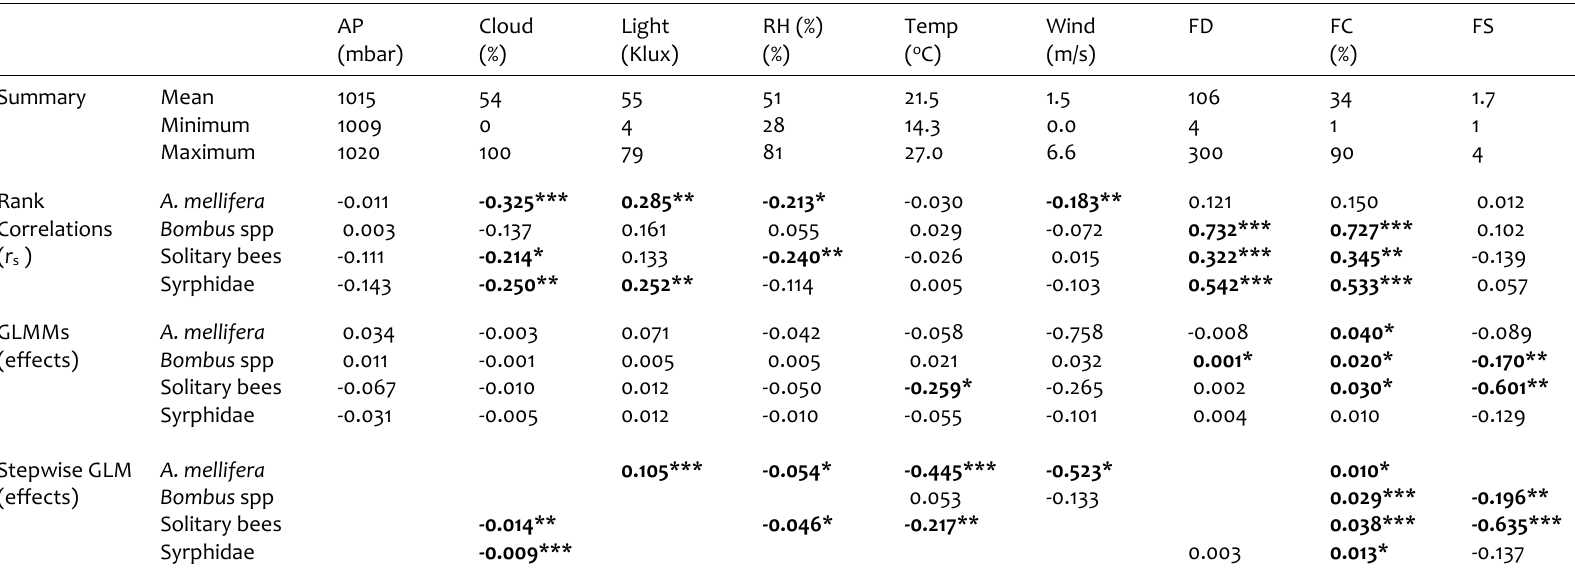
Table 2. Summary of weather and floral unit parameters occurring in 120 30-minute timed pollinator counts in 2 x 2 m plots at Rosemount Orchard, Dublin. Relationships between explanatory variables and counts of four pollinator groups ( Bombus spp, Apis mellifera , solitary bees, Syrphidae) are given as pairwise rank correlation coefficients, effects in GLMMS (with sampling day included as a random factor) and effects in GLMs obtained by stepwise modelling using AIC to indicate best model. Figures highlighted bold indicate statistically significant effects (* P < 0.05; ** P < 0.01; *** P < 0.001). Parameters tested are: air pressure (AP), cloud cover, light intensity, relative humidity (%), temperature, wind speed, floral unit density (FD), floral cover (FC), and floral species richness